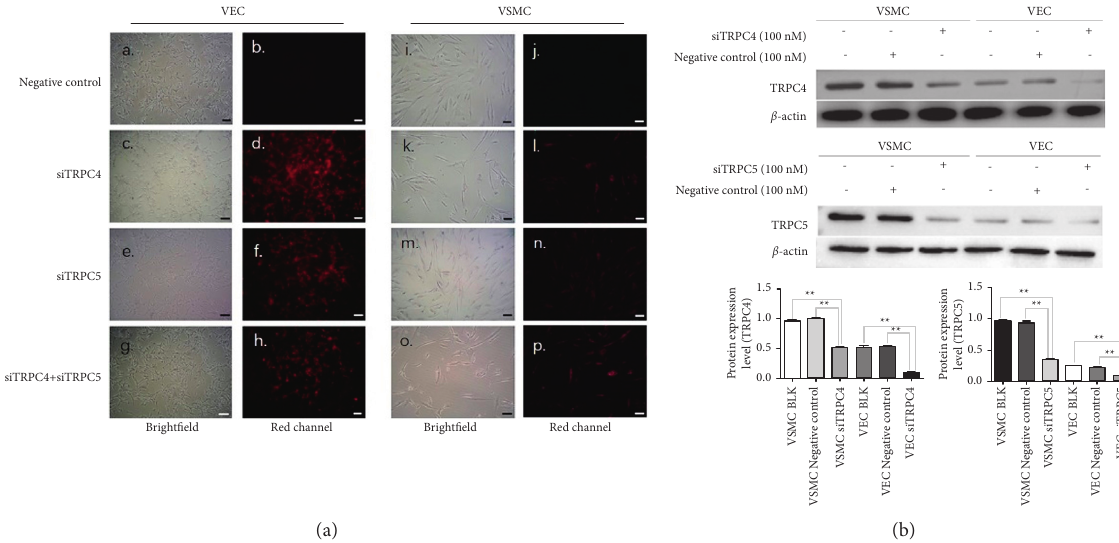
Figure 2: (a) siTRPC4 (100nM) and siTRPC5 (100nM) were transfected into VECs and VSMCs, and cells were examined 48h after transfection by fluorescence microscopy. a and b are unlabeled Cy3 negative controls for transfection of VECs for 48h; c and d are TRPC4 siRNA (100nM) for transfection of VECs for 48h, e and f are TRPC5 siRNA (100nM) for transfection of VECs for 48h; g and h are TRPC4 siRNA (100nM) and TRPC5 siRNA (100nM) which were cotransfected into VECs for 48h. Among them, a, c, e, and g are observations of cell morphology after transfection under brightfield, b, d, f, and h are observations of transfection efficiency under the red fluorescence channel, i and j are unlabeled Cy3 negative controls for transfection of VSMCs for 48h, k and l are TRPC4 siRNA (100nM) for transfection of VSMCs for 48h, m and n are TRPC5 siRNA (100nM) for transfection of VSMCs for 48h, and o and p are TRPC4 siRNA (100nM) and TRPC5 siRNA (100nM) which were cotransfected into VSMCs for 48h. Among them, i, k, m, and o are observations of cell morphology after transfection under brightfield, and j, l, n, and p are observations of transfection efficiency under the red fluorescence channel. Scale bars � 50 μ m. (b) After expressions of TRPC4 and TRPC5 were suppressed using an siRNA strategy, TRPC4 and TRPC5 protein expression levels were measured by western blotting. BLK: blank group. N � 12. ∗ p < 0 . 05 vs. VSMC-CTRL, VSMC siTRPC4, and VSMC siTRPC5. ∗∗ p < 0 .